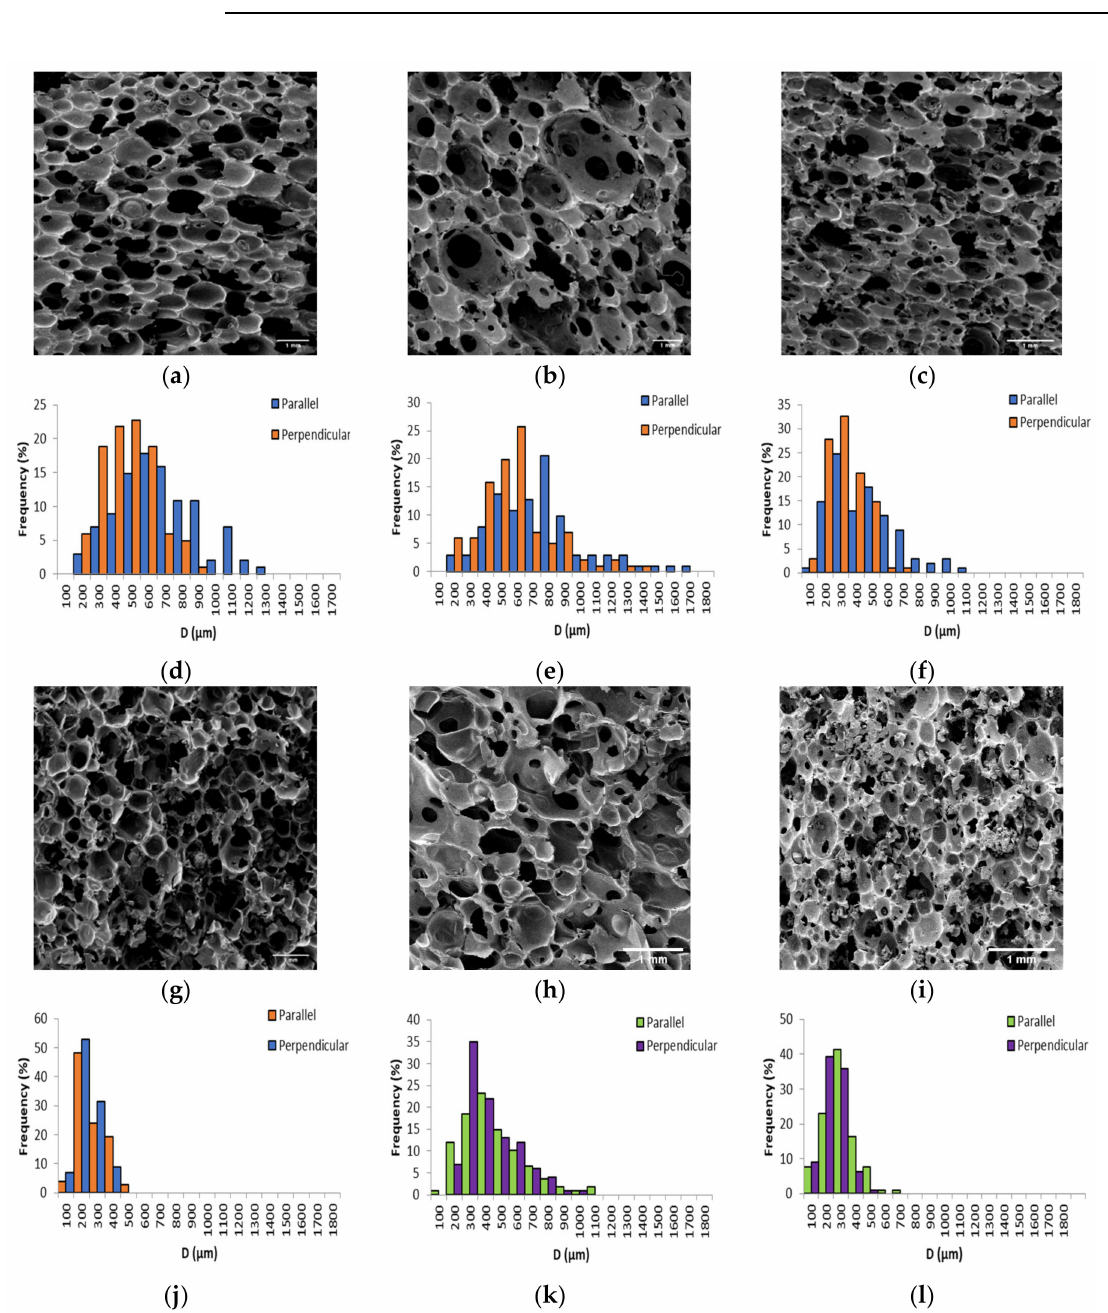
Figure 3. ( a – c ) SEM micrograph of PF1a, PF1b, and PF1c, ( d – f ) cell diameter distribution of PF1a, PF1b, and PF1c, ( g – i ) SEM micrograph of PF1d, PF2a, and PF2b, and ( j – l ) cell diameter distribution of PF1d, PF2a, and